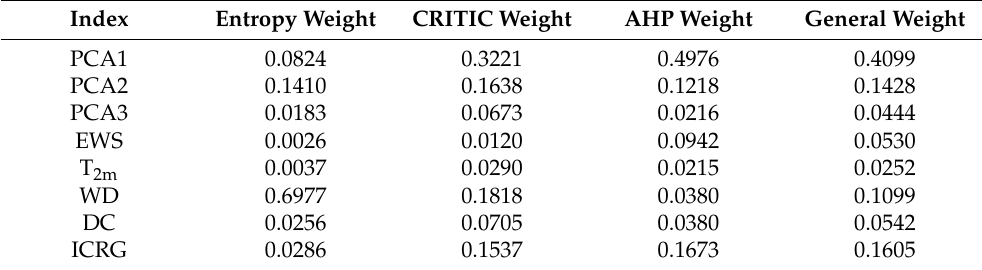
Table 5. Entropy weight, CRITIC, analytic hierarchy process and general weight